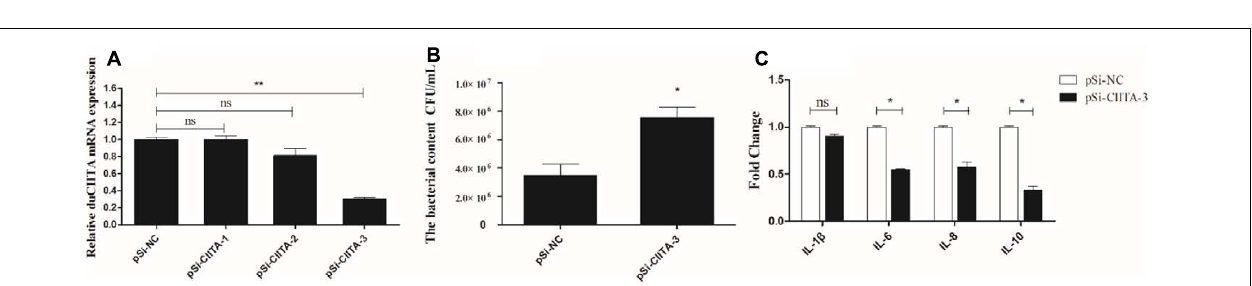
different duCIITA expression in the liver, spleen, and brain.